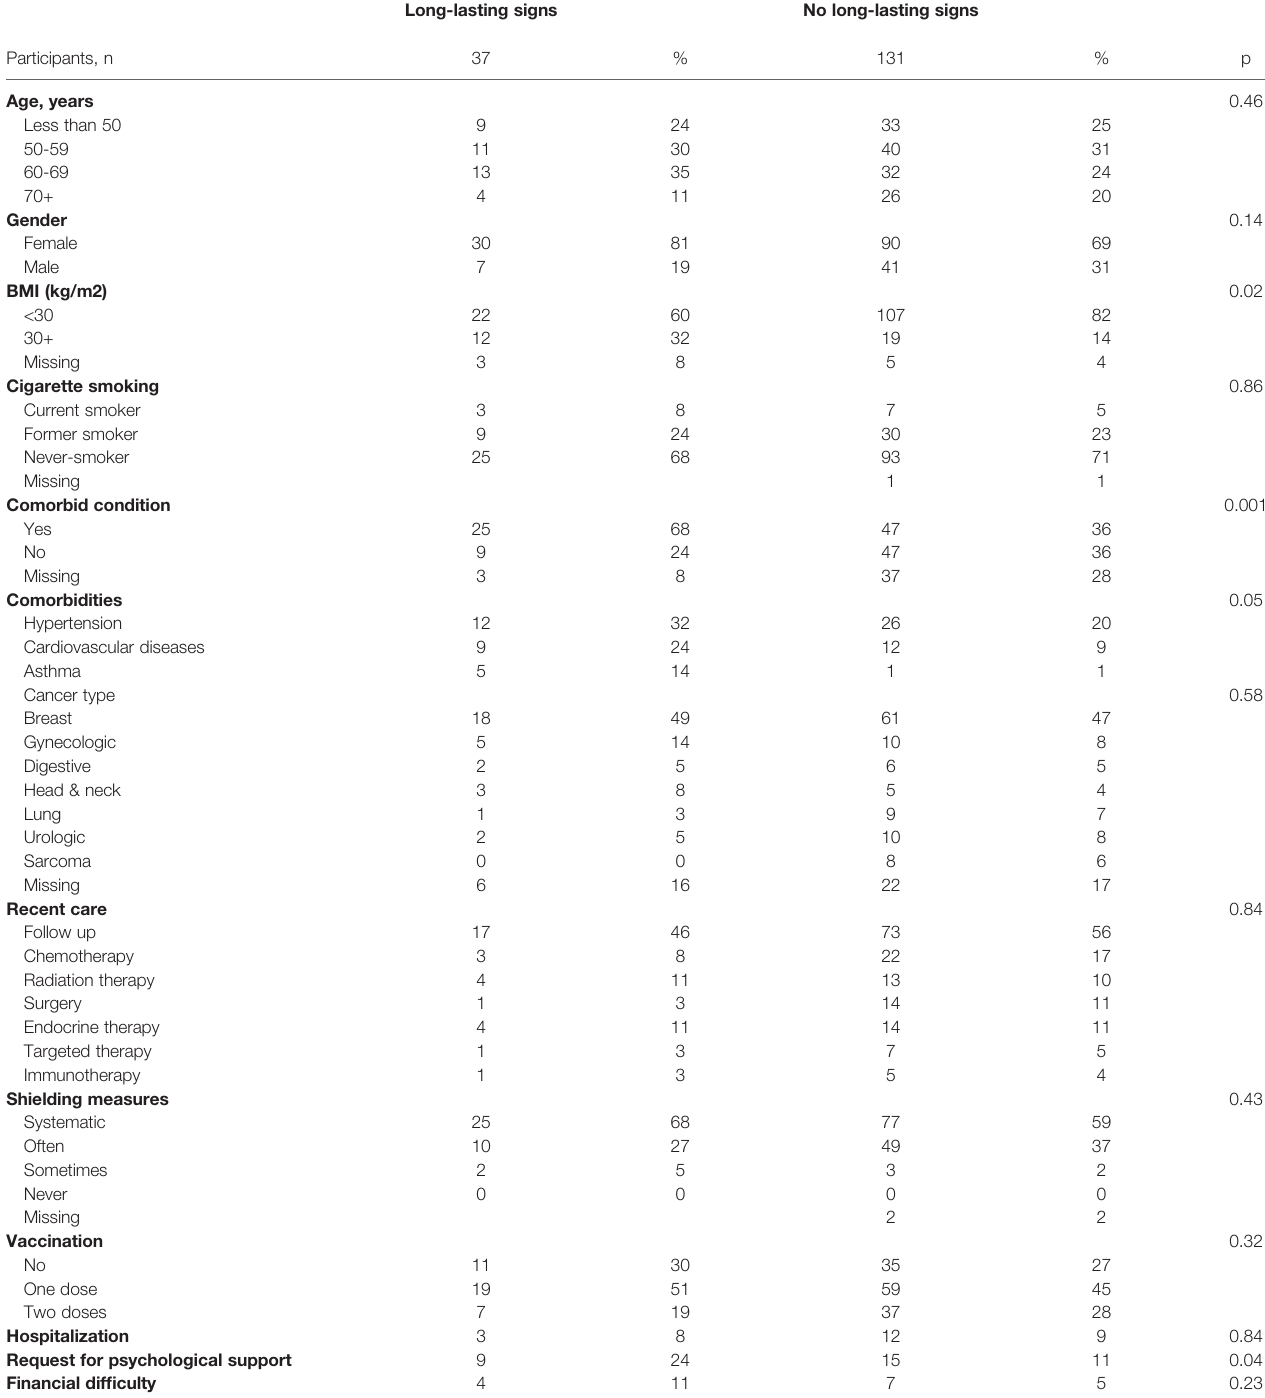
TABLE 2 | Patients ’ characteristics among infected patients in cohort 2 according to long-lasting